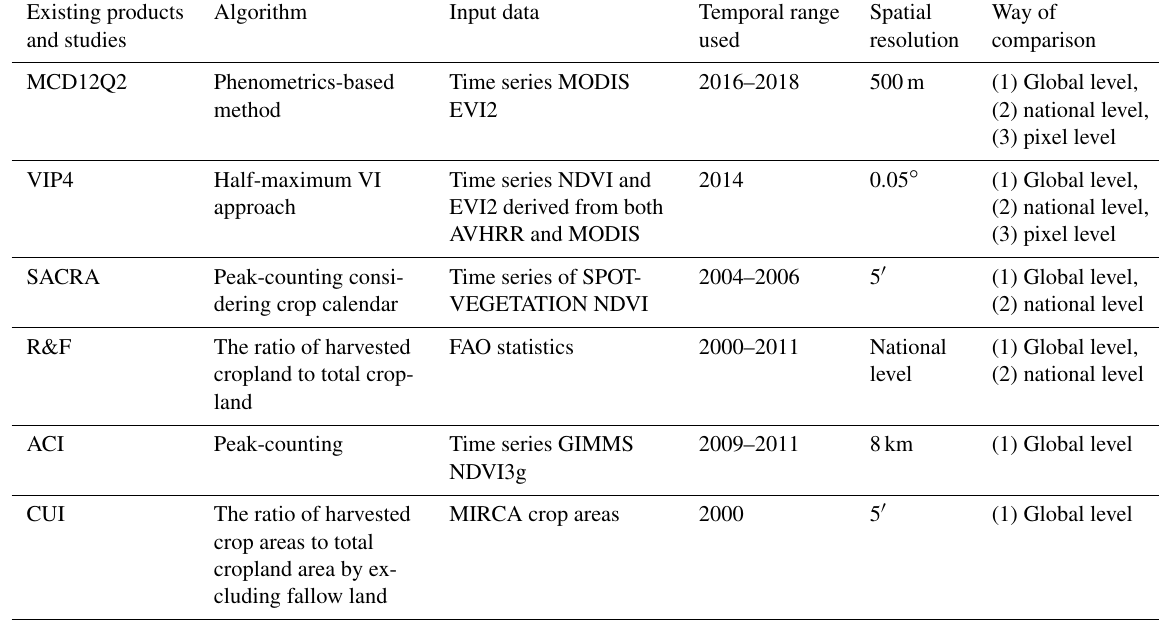
Table 1. Existing cropping intensity products or studies used for intercomparison. Existing